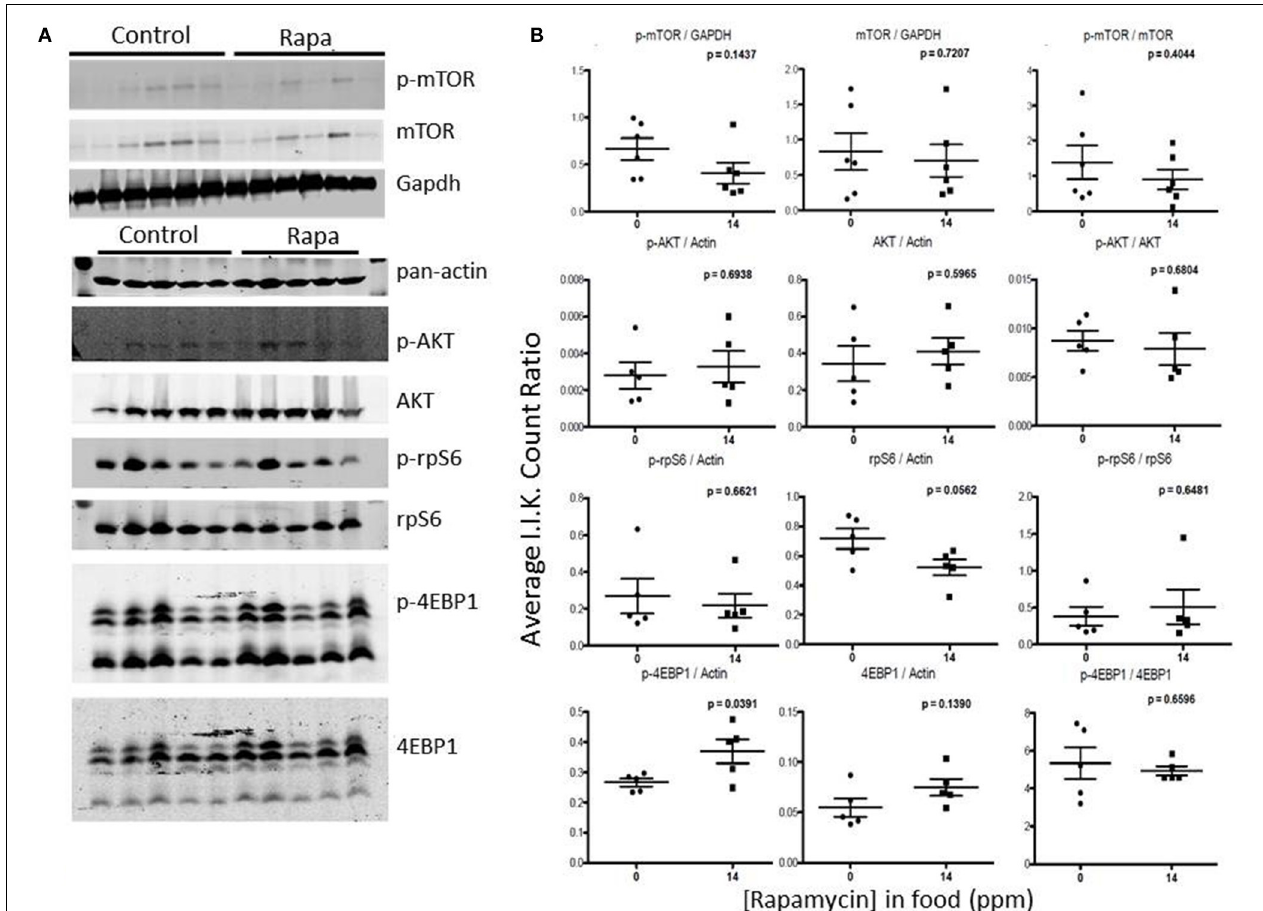
FIGURE 7 | Liver lysates from female C57BL6 mice did not show a clear pattern of change in mTOR signaling. (A) Liver lysates from 25 month female rapamycin-treated and control animals were analyzed by Western blot